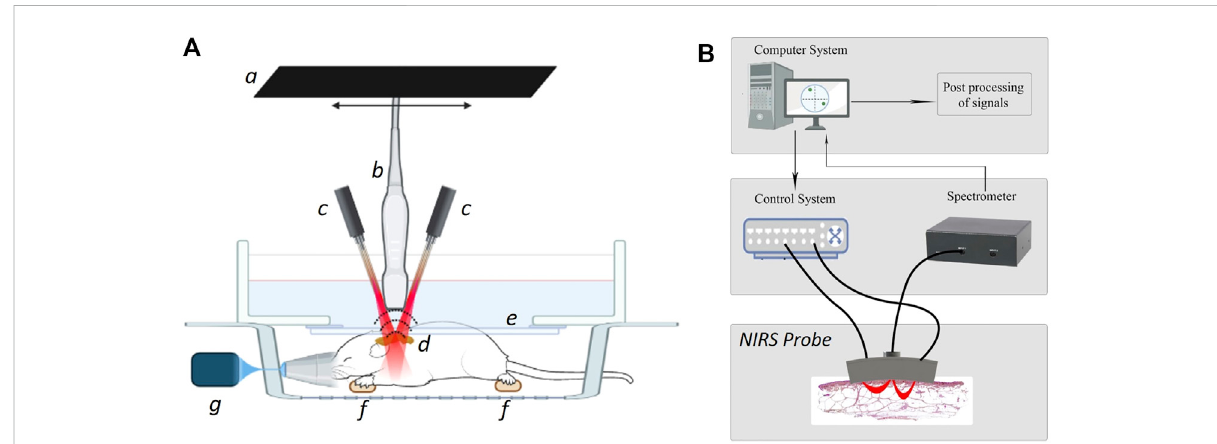
FIGURE 2 Schematic of the ultrasound-photoacoustic (US-PA) whole-body acquisition setup (A) that includes: a linear stepper motor (a), the ultrasound transducer (b) with optical fi bers on the sides (c) to illuminate the tissue chromophores (d), optical and acoustic compatible membrane (e) in a water bath to maintainthesoundcoupling, ECGelectrodes to monitor thephysiological parameters invivo (f),and theanesthesiasystem (g).Schematicof thenear-infrared spectroscopy (NIRS) optical probesetup (B) that also includes: a control system for theoptical source, aspectrometer for the detection, and a computer for the signals post-processing.